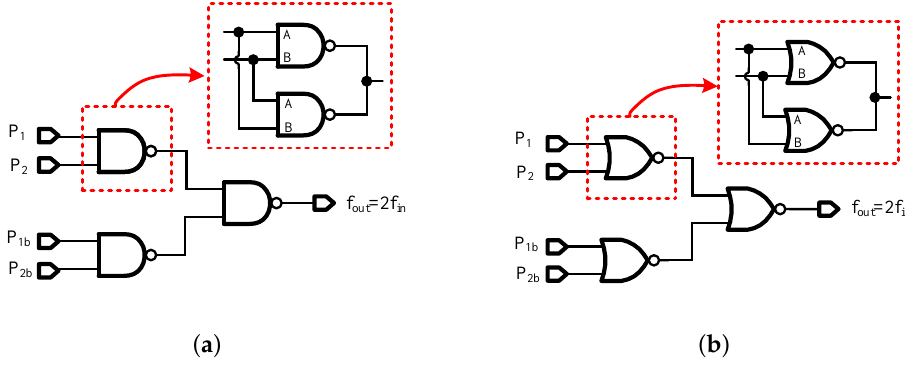
Figure 10. Unit edge combination circuit. ( a ) Edge combiner implemented with NAND gates; ( b ) Edge combiner implemented with NOR gates.